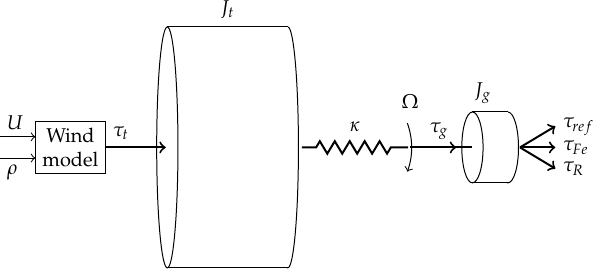
Figure 4. The simulation model based on rotational